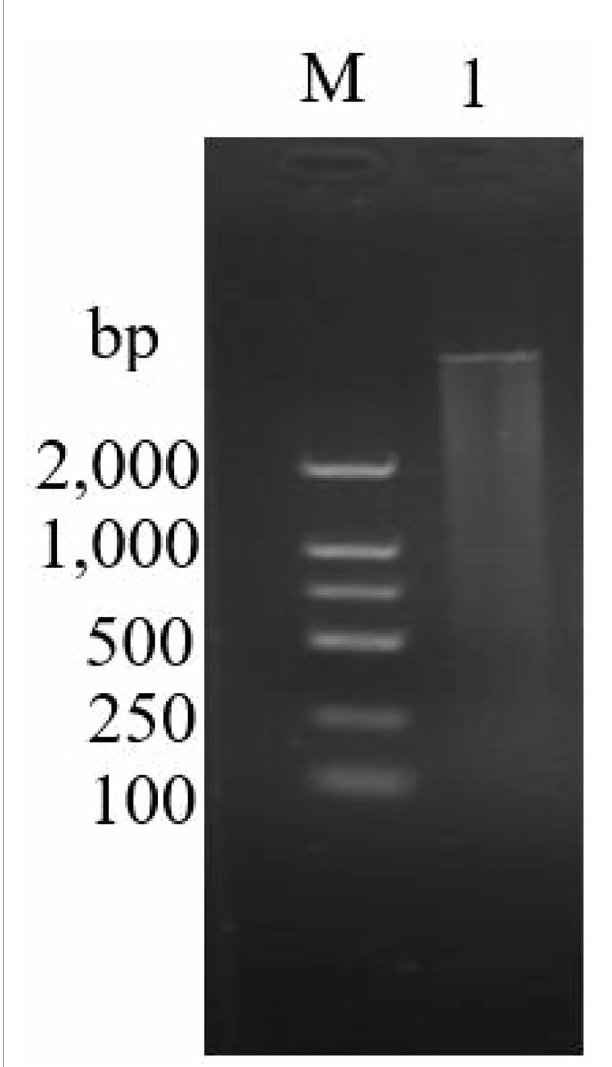
FIGURE 7 | Long-distance PCR for second-strand cDNA synthesis. M: DL 2000 Marker. 1: Second-strand cDNA. The length of cDNA molecules was more than 200